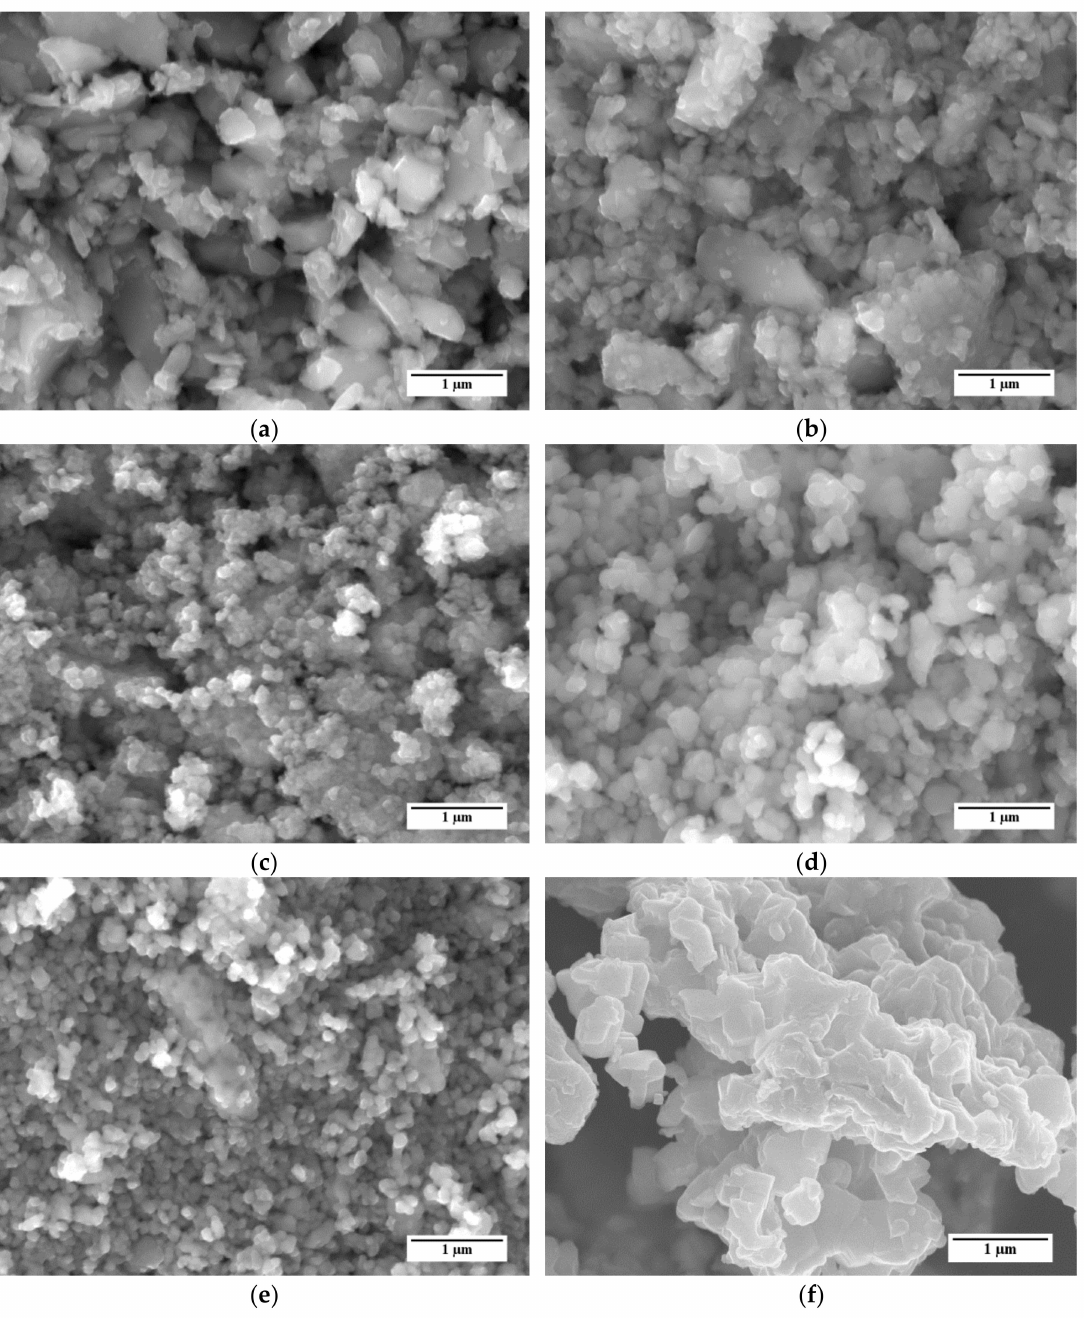
Figure 2. SEM micrographs of the La 0.6 Sr 0.4 Co 0.2 Fe 0.8 O 3 − δ (LSCF) powders considered in this study: ( a ) Powder A; ( b ) Powder B; ( c ) Powder C; ( d ) Powder D; ( e ) Powder E; ( f ) Reference